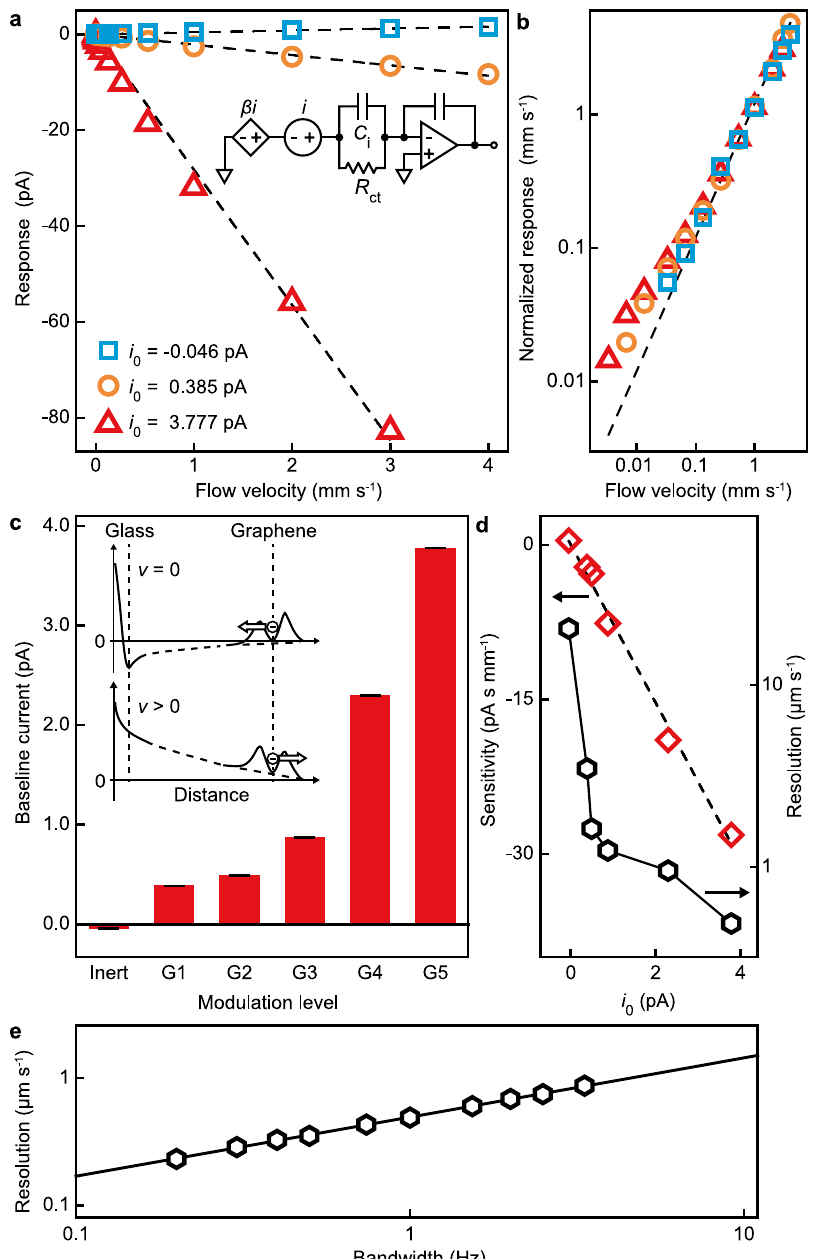
Fig. 2 Response curves and characteristics for blood- fl ow-velocity quanti fi cation by the graphene single-microelectrode device. a The current response as a function of fl ow velocity. In the circuit, β is the scaling factor that models the modulation of the graphene charge-transfer current ( i ) by an unbiased non-faradaic electrode made of glass with variable surface charge density and i 0 is the baseline current (the current at zero fl ow velocity). The dash lines are best proportional fi ts to the data. The linear electrical circuit models the charge-transfer current through the graphene/blood interface represented by a charge-transfer resistance ( R ct = 1/ σ ct ) and an interfacial capacitance ( C i ). b The sensitivity-normalized current response as a function of fl ow velocity. The eye-guiding dash line is of the unit slope. The data symbols are the same as in ( a ). c The baseline current (at zero fl ow velocity) measured with (G1 – 5) and without (Inert) using an unbiased glass electrode. The energy pro fi le diagram illustrates the modulating effect of the charged glass electrodes on the graphene – blood electron transfer through a graphene-defect electronic state when the magnitude of the fl ow velocity ( v ) increases. The vertical dashed line on the glass (graphene) side represents the glass/blood (graphene/blood) interface. The error bars are charge-transfer current standard deviations in 1-Hz bandwidth. d Resolution and sensitivity as a function of the baseline current i 0 . The dash line is a proportional fi t to the sensitivity data. e Resolution as a function of bandwidth for i 0 equal to 3.777 pA (G5). The black line is based on the parameters of the best linear fi t to the data. In a , b , d , and e , the sizes of the error bars (the standard deviations of corresponding quantities based on the current uncertainties over the measurement bandwidth (1 Hz for a , b , and d )) are smaller than the size of the data points.